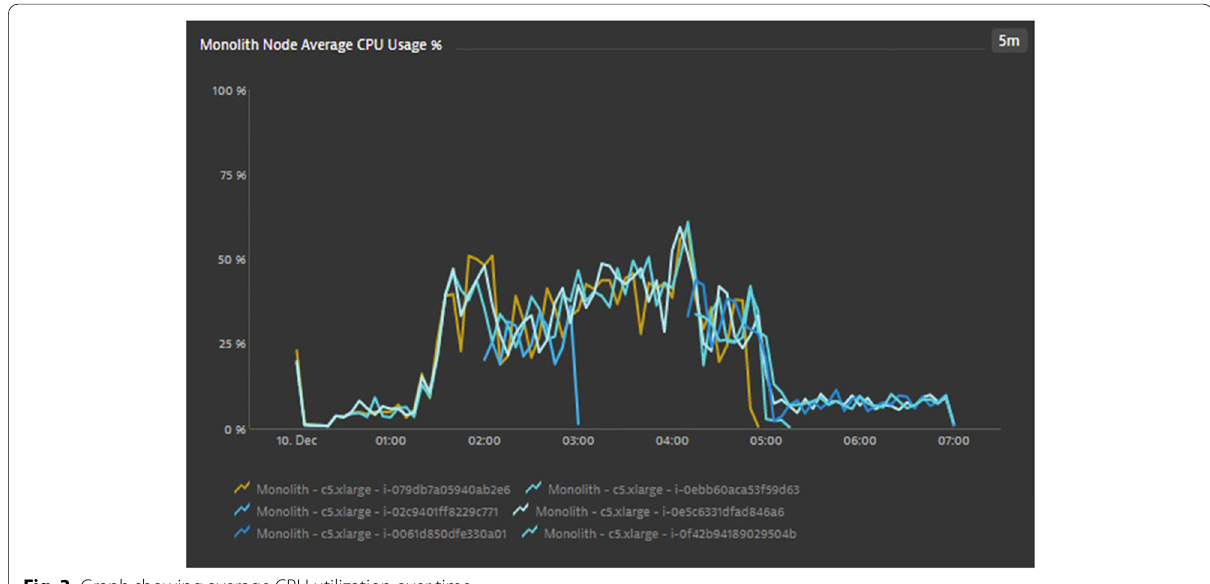
Fig. 3 Graph showing average CPU utilization over